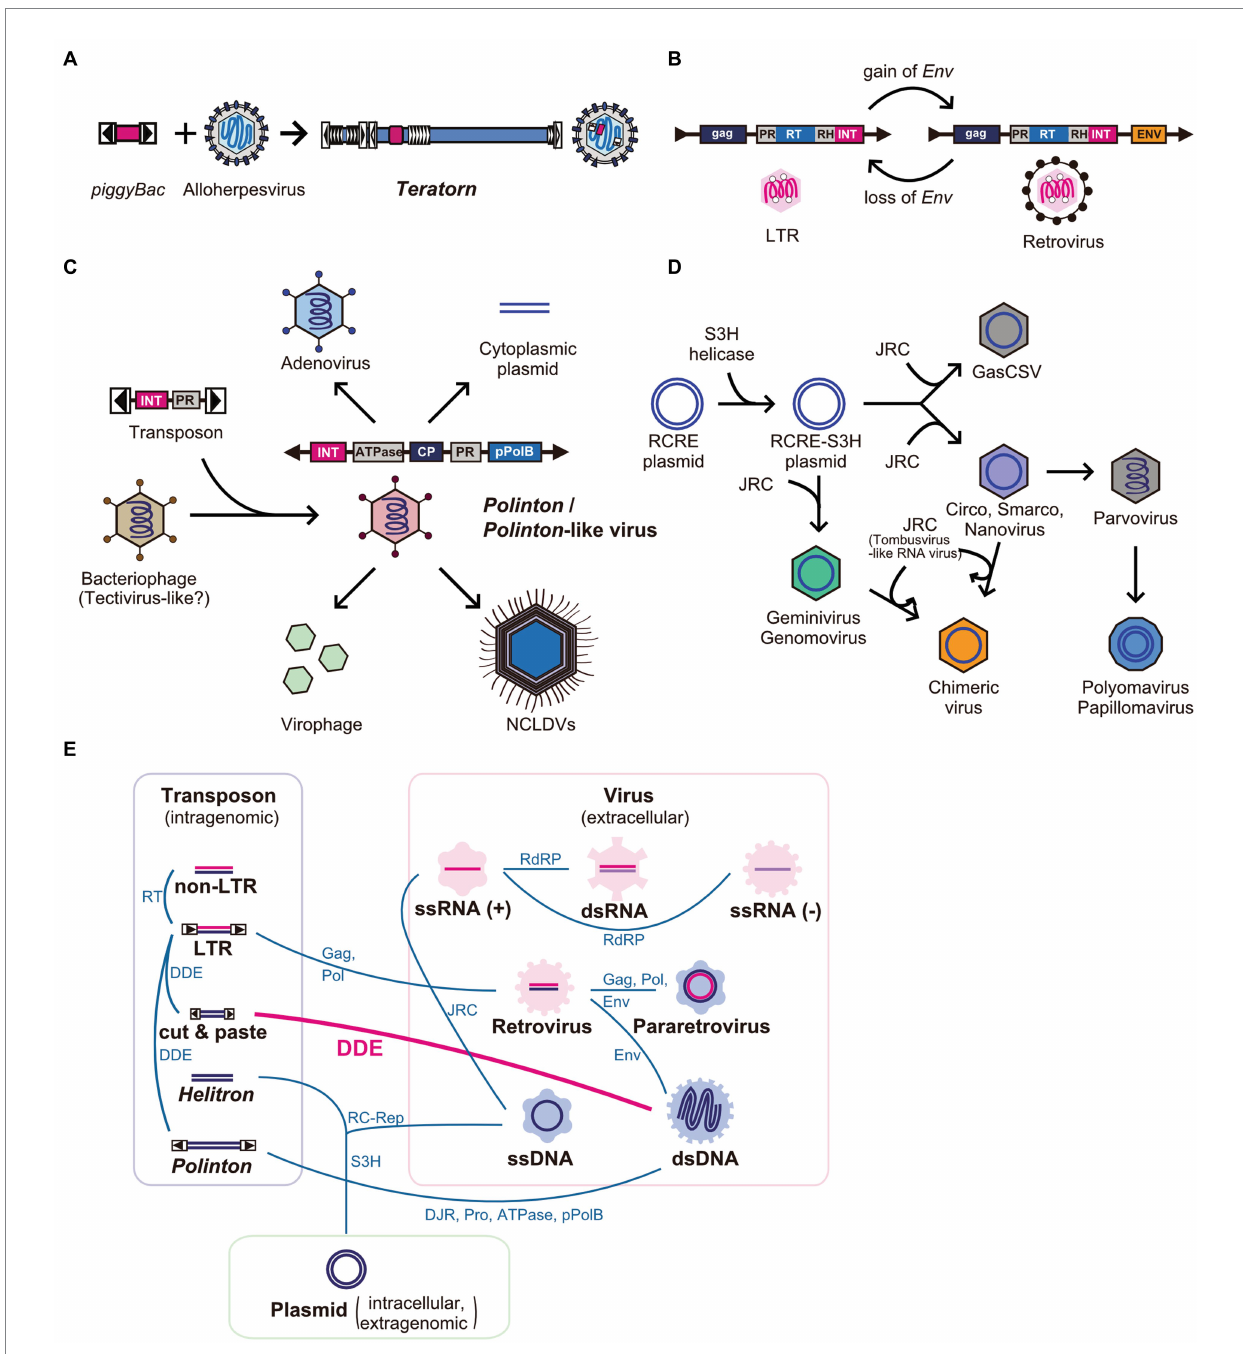
FIGURE 5 Network-like evolutionary relationships in eukaryotic mobile genetic elements and viruses. (A–D) Examples of the emergence of novel mobile genetic elements by recombination between different class of elements. (A) Teratorn (B) LTR retrotransposons and retroviruses (C) Polintons and several dsDNA viruses, adapted from (79) (D) ssDNA viruses, adapted from (80). Abbreviations; PR, protease; RH, RNA helicase; RT, reverse-transcriptase; Env, envelope protein; INT, retrovirus-like integrase; CP, capsid protein; pPolB, protein-primed family B DNA polymerase; NCLDV, nucleocytoplasmic large DNA virus; RCRE, rolling-circle replication endonuclease; JRC, jerry-roll capsid. (E) Network-like evolutionary relationships in eukaryotic mobile genetic elements and viruses. Evolutionary relationships between different classes of mobile elements are connected by lines. Shared genes are represented next to the lines. Abbreviations; ATPase, DNA packaging ATPase; DDE, DDE transposase; DJR, double jelly-roll capsid; Env, envelope protein; Gag, group-specific antigen; JRC, jelly-roll capsid; pPolB, protein-primed family B DNA polymerase; Pro, Ulp1-like cysteine protease;